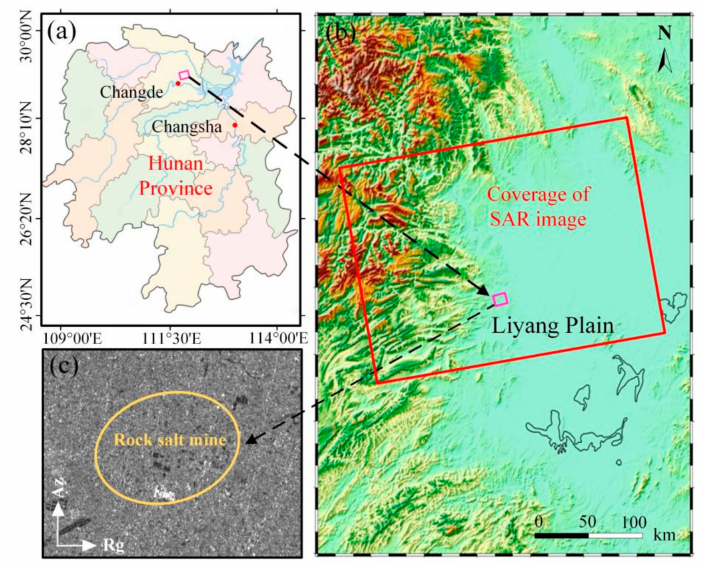
Figure 7. Study area and SAR spatial coverage: ( a ) map of Hunan Province; ( b ) coverage of SAR images; ( c ) mean amplitude image of the study